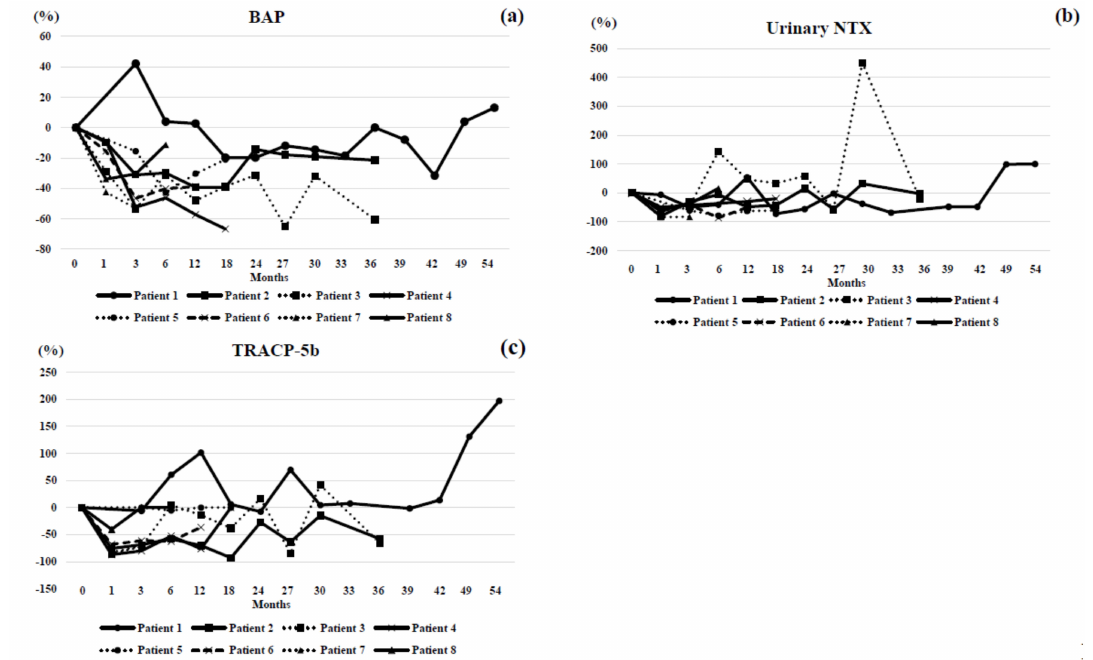
Figure 3. Changes in bone turnover markers before and during denosumab administration. ( a ) Only in Patient 1, the percent changes in bone alkaline phosphatase (BAP) were increased for the first 3 months, and then decreased or slightly increased thereafter. In other patients, they tended to be decreased during the observation period. ( b ) In Patient 3, the percent changes in urinary NTX were increased during 6 to 24 months, and then sharply increased at 30 months. In other patients, they were mostly constant or slightly inhibited during follow-up. ( c ) In Patient 1, the percent changes in TRACP-5b were increased at 6, 12, 27, 49, and 54 months. In other patients, they were mostly constant or slightly inhibited during the treatment period. Patient 1: circles connected by a solid line. Patient 2: squares connected by a solid line. Patient 3: squares connected by a dotted line. Patient 4: cross marks connected by a solid line. Patient 5: circles connected by a dotted line. Patient 6: cross marks connected by a hashed line. Patient 7: triangles connected by a dotted line. Patient 8: triangles connected by a solid line. Circles, squares, and triangles represent family